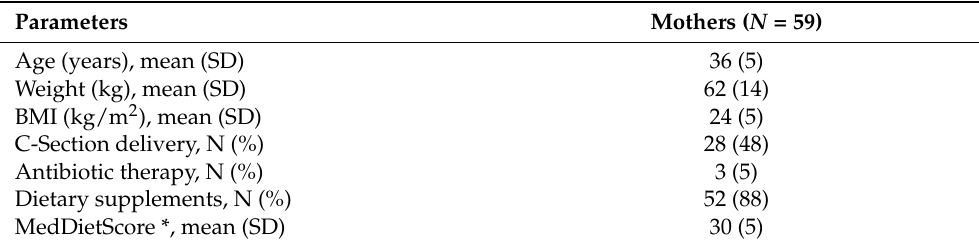
Table 1. Demographic and clinical characteristics of participants at time point ‘Recovery of Birth Weight’ or ‘Complete Enteral Nutrition’ for mothers of term and preterm infants, respectively.